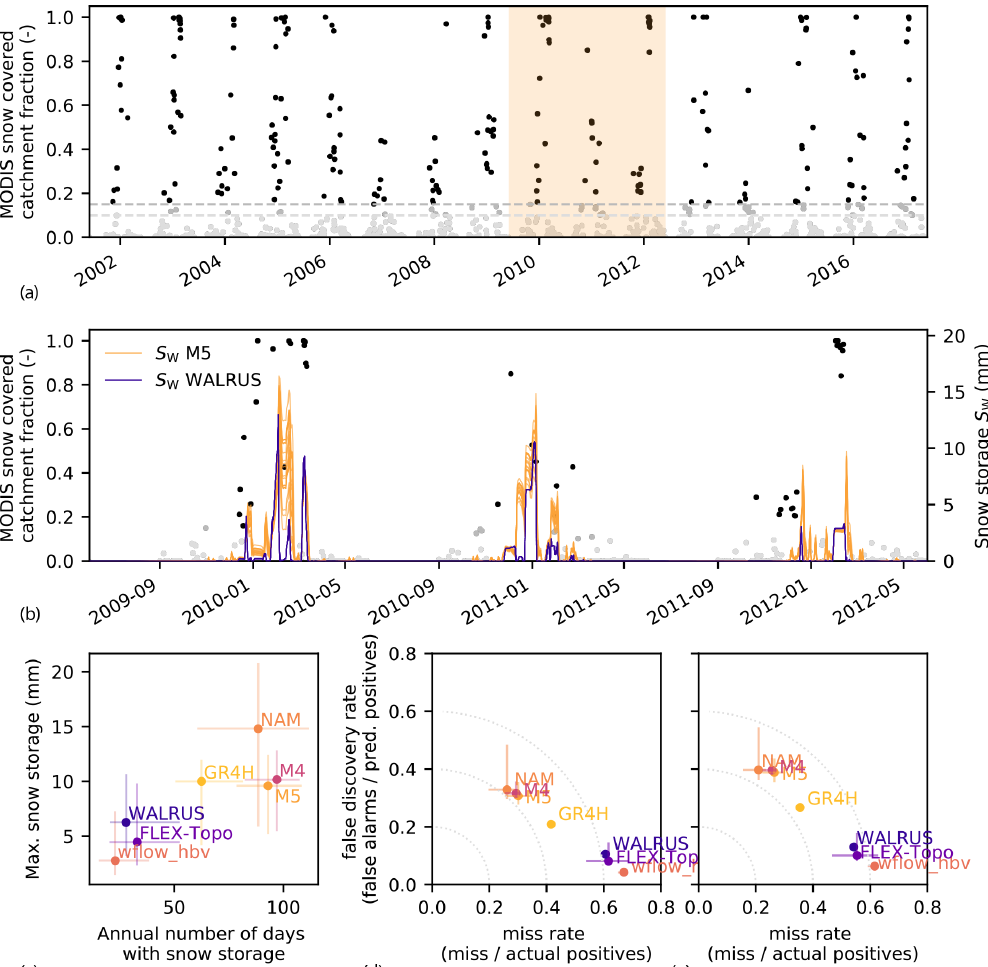
Figure 5. (a) Fraction of cells with a MODIS areal fraction snow cover greater than zero in the Ourthe Orientale upstream of Mabompré for the period 2001–2017. MODIS data are available once every 3d on average. The dashed lines show the two thresholds of 10% and 15% selected to distinguish snow days. (b) Modeled snow storage for two contrasting models M5 and WALRUS for the light orange shaded period. (c) Median annual maximum snow storage as a function of number of days per year with snow. Light (yellowish) colors indicate models with higher performance (lower Euclidean distances). The vertical and horizontal error bars indicate the 25th/75th percentiles over time and feasible parameter sets. (d, e) Two-dimensional representation of the false discovery rate as a function of the miss rate when applying thresholds of (d) 10% and (e) 15% of cells within the catchment with snow cover greater than zero. In this representation, the perfect model would be at the origin (0% misses and 0% false alarms). The dotted lines show the distance from the origin. The vertical and horizontal error bars indicate the uncertainty within feasible parameter